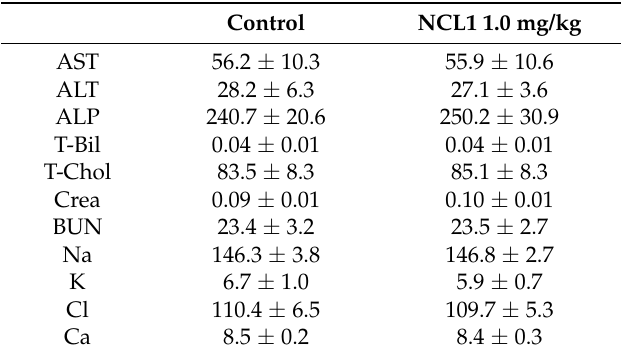
Table 2. Blood results at the experiment’s termination in a PCai1mouse tumor model. AST: aspartate aminotransferase; ALT: alanine aminotransferase; ALP: alkaline phosphatase; T-Bil: total bilirubin; T-Chol: total cholesterol; Crea: creatinine; BUN: blood urea nitrogen; Na: sodium; K: potassium; Cl: chloride; Ca: calcium. Mean ± standard deviation